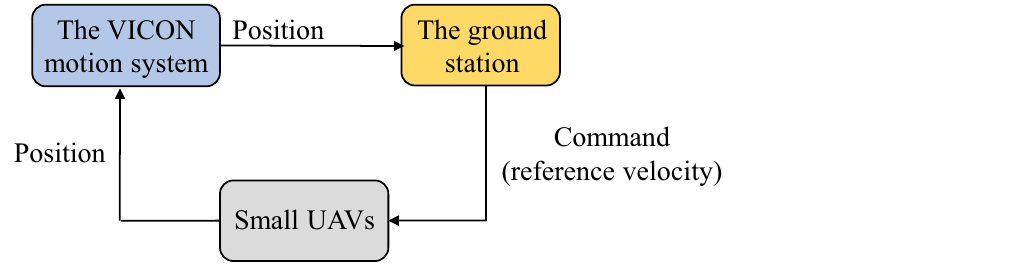
Figure 12. Experimental setup for real flight tests.